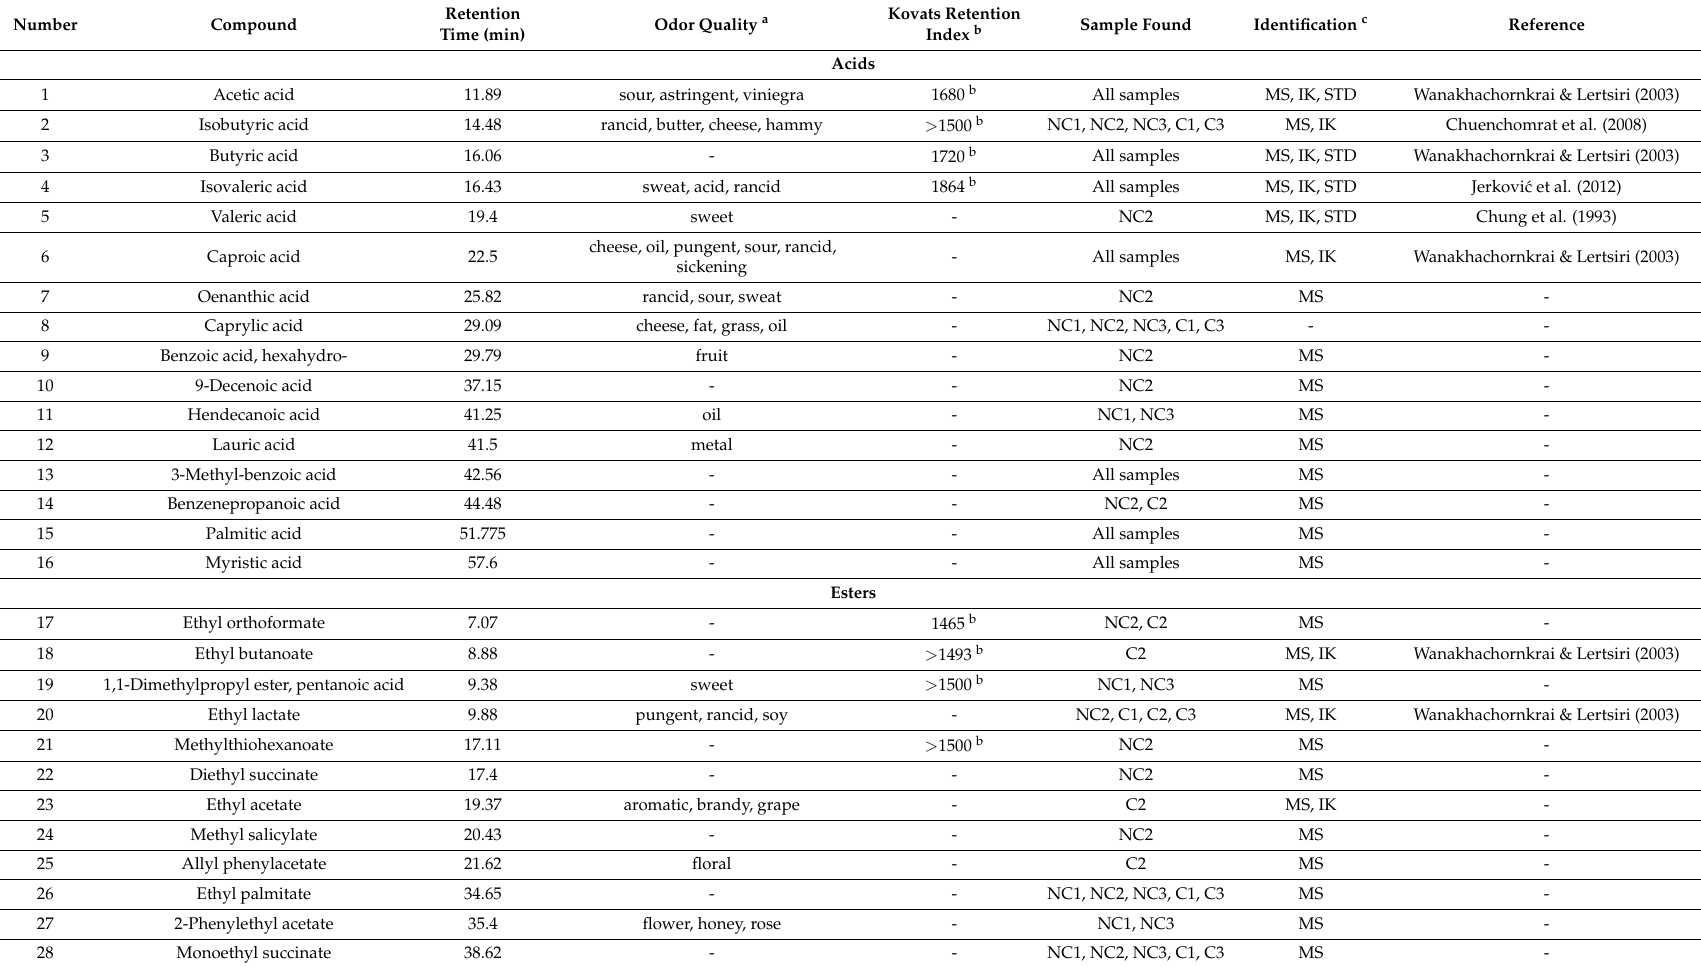
Table 1. Volatile compounds identified in tequila vinasses, using gas chromatography coupled with mass spectrometry